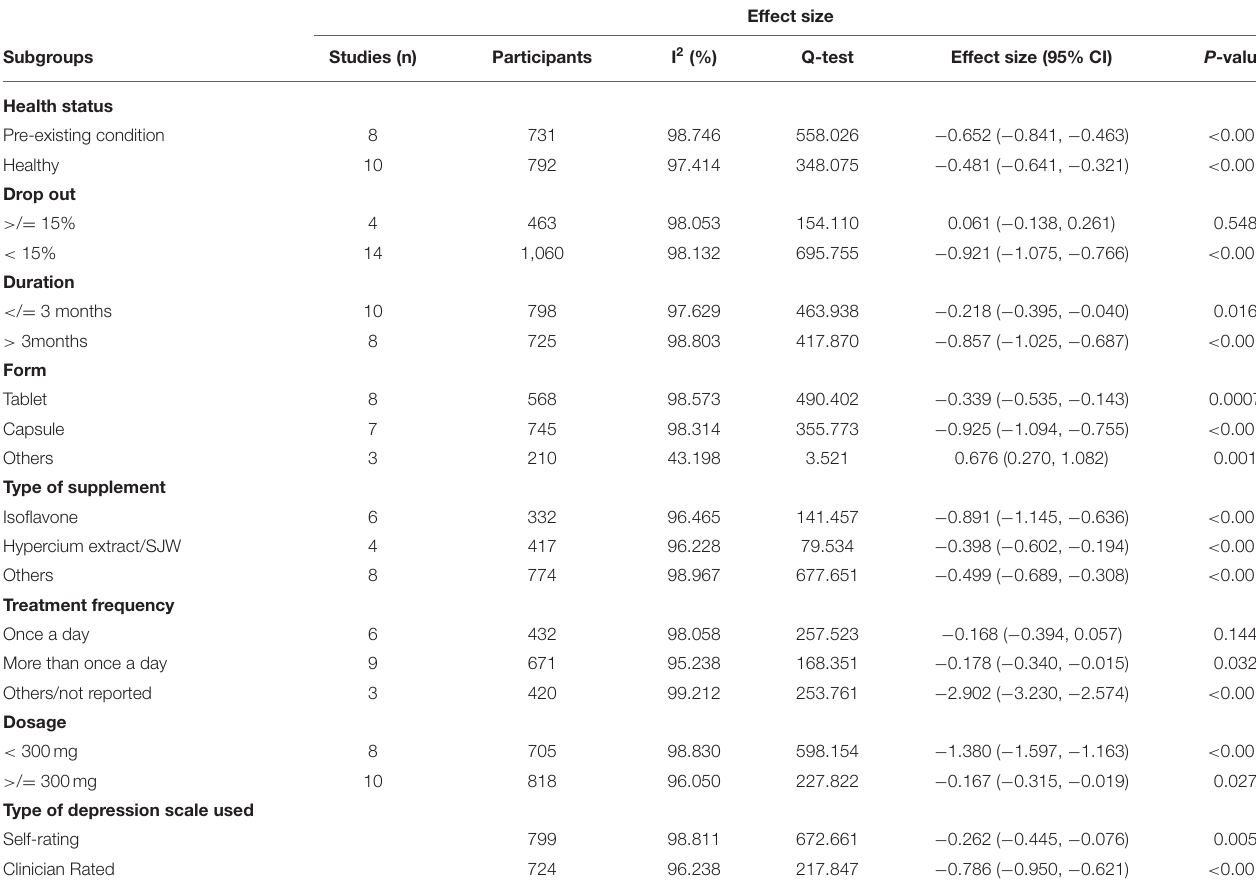
TABLE 3 | Subgroup analysis on the effect of polyphenol on depression.